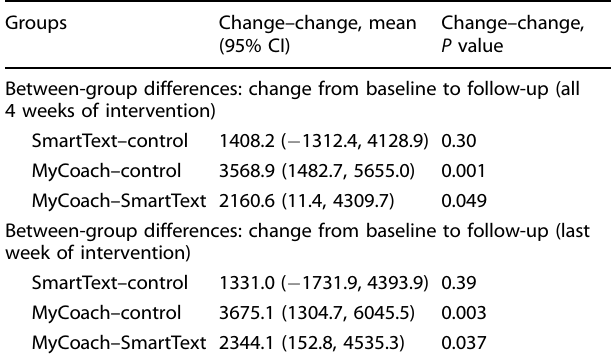
Table 3. Between-group differences: change from baseline to follow-